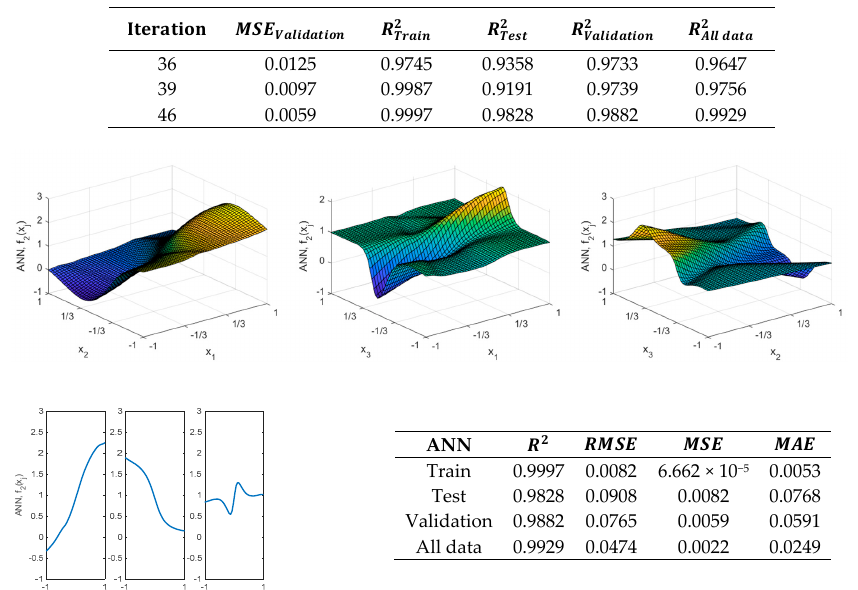
Figure 14. Response surfaces obtained, main effects plot and results of the validation metrics obtained with the ANN model for the case of type 2 function ( f 2 ) ( n = 8 neurons ) .